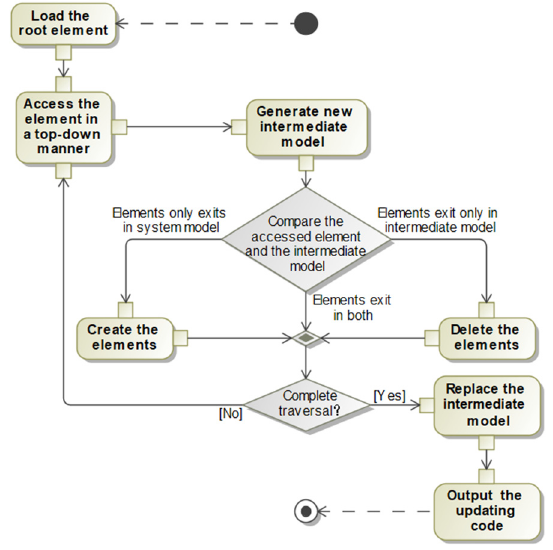
Figure 11. Model transformation and synchronization process.